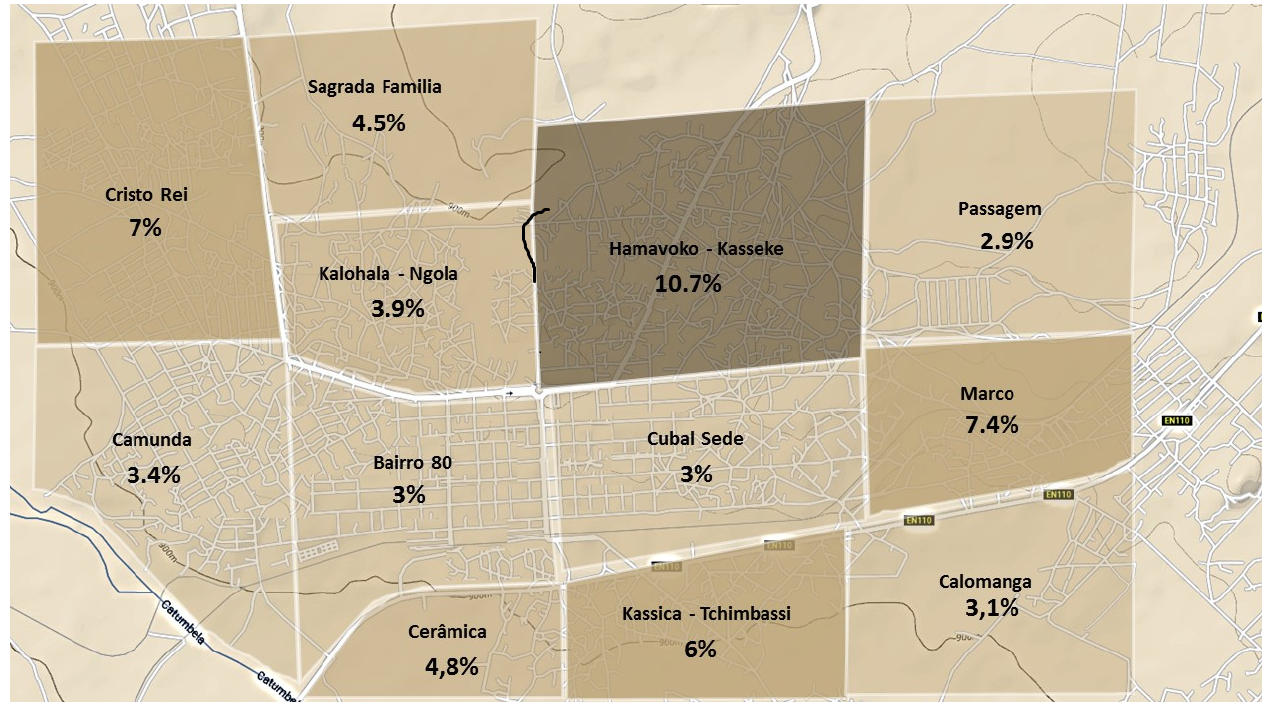
Figure 2. Map of Cubal with its neighborhoods. The fold change in the increase in incidence rate is represented. Cases per 1000 population between 2014 and 2016.